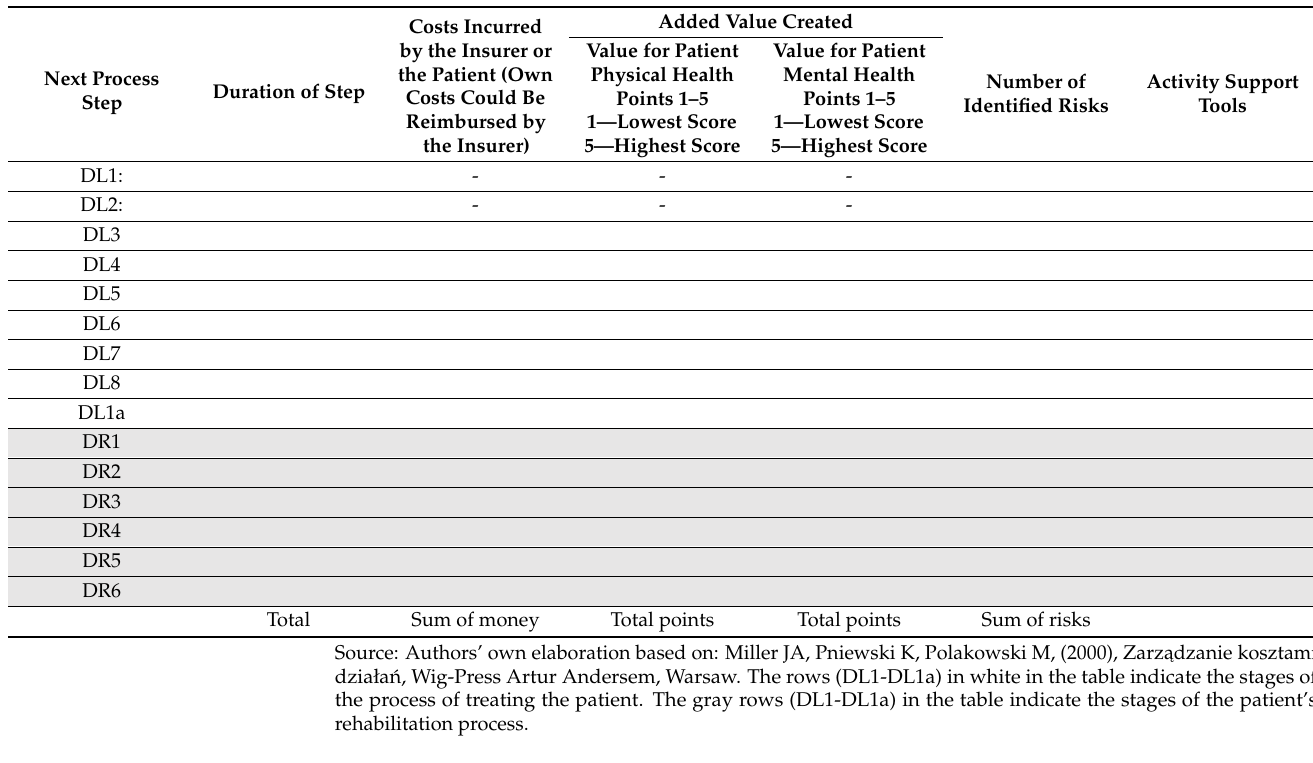
Table 2. A detailed form for assessing the steps that make up the processes of treatment and rehabilitation of patients following a specific injury, i.e., trimalleolar fracture of ankle joint.